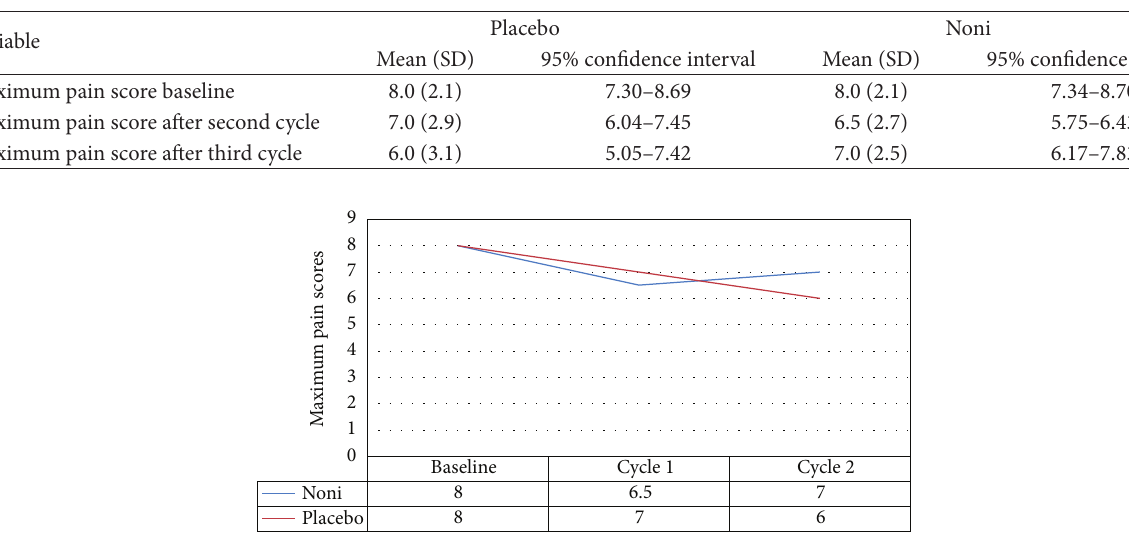
Values are mean maximum pain score F 2: Comparison of the effects of noni versus placebo on pain